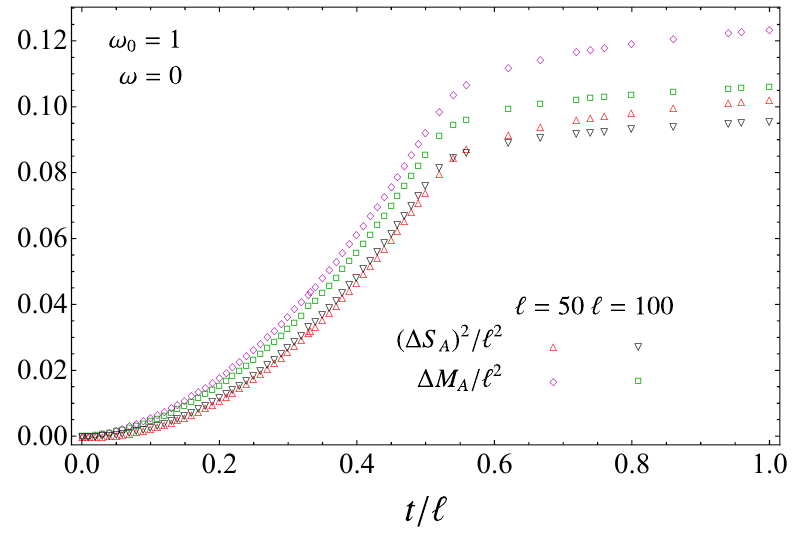
Figure 6 . Temporal evolutions of ∆ M A and of (∆ S A ) 2 of a block of ‘ consecutive sites in an infinite harmonic chain after a global quantum quench of the mass